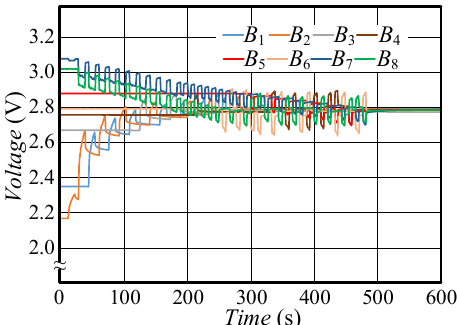
Figure 10. Battery voltage variations during offline balancing. Table 2. Battery voltages during o ffl ine balancing.